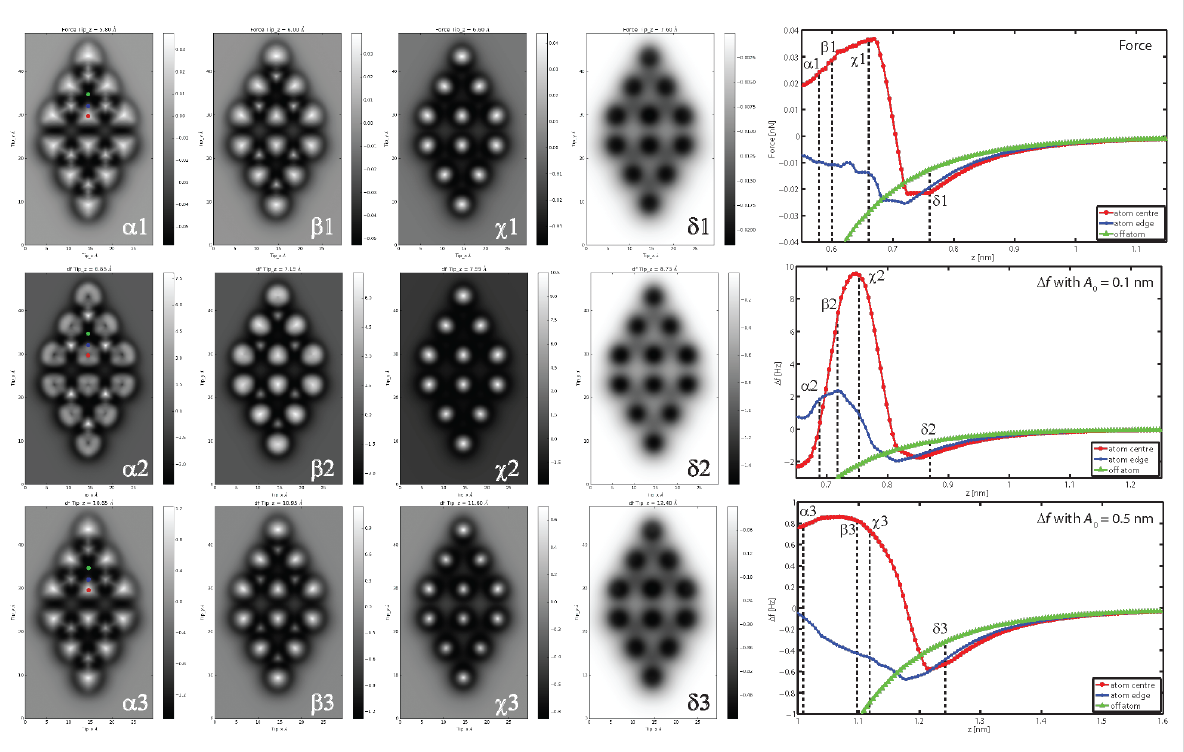
Figure 3: Comparison of the evolution in force (top row) and frequency shift (lower two rows). The evolution in Δ f is shown for oscillation amplitudes of 0.1 nm (middle row), and 0.5 nm (lower row). The position of single F ( z ) and Δ f ( z ) curves are marked on the xy images, and the heights of each image is marked on the graphs with the corresponding Greek letter. The Δ f contrast and evolution in z is qualitatively similar for the force and 0.5 nm oscillation amplitude simulations. The simulations with an oscillation amplitude of 0.1 nm show an dark region in the centre of the adatoms, which is reflected in the inversion observed in the Δ f ( z )